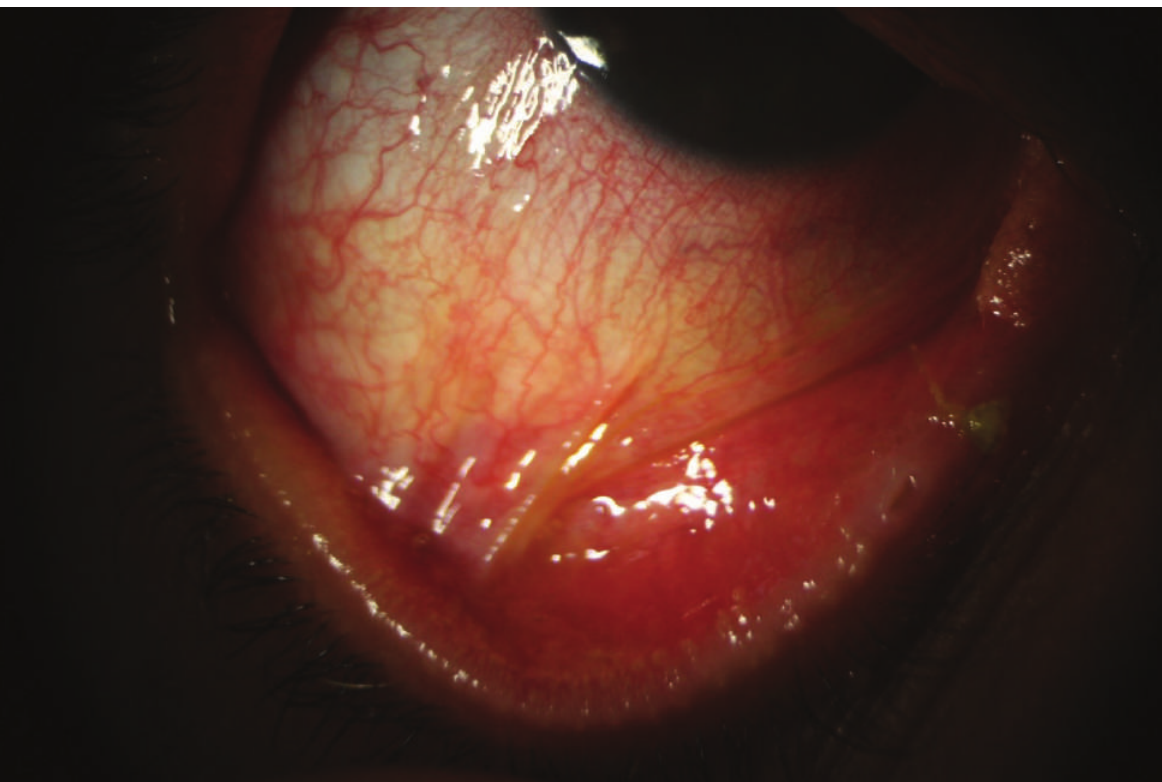
Figure 8. Symblepharon formation in a patient with ocular cicatricial